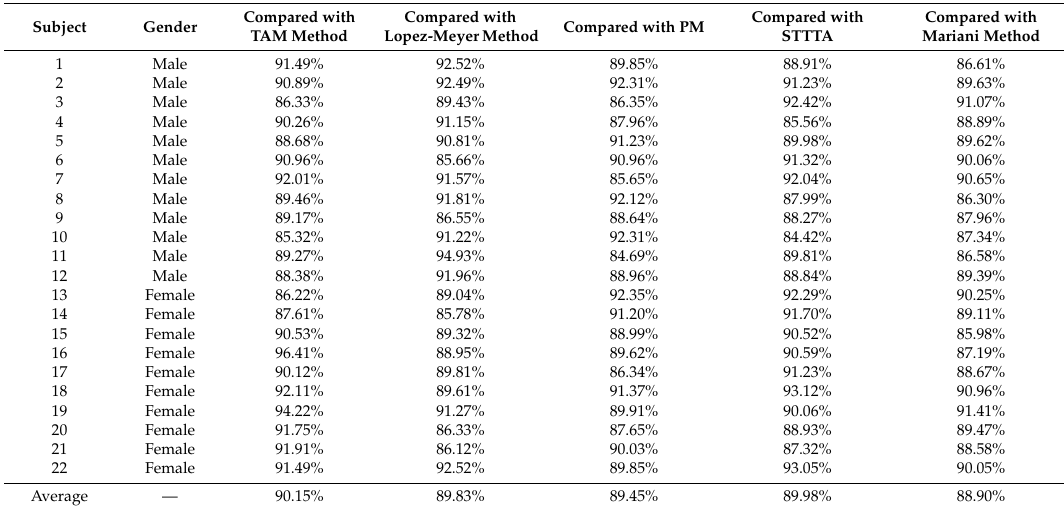
Table 2. Reliability of the proposed method compared with the reference methods.